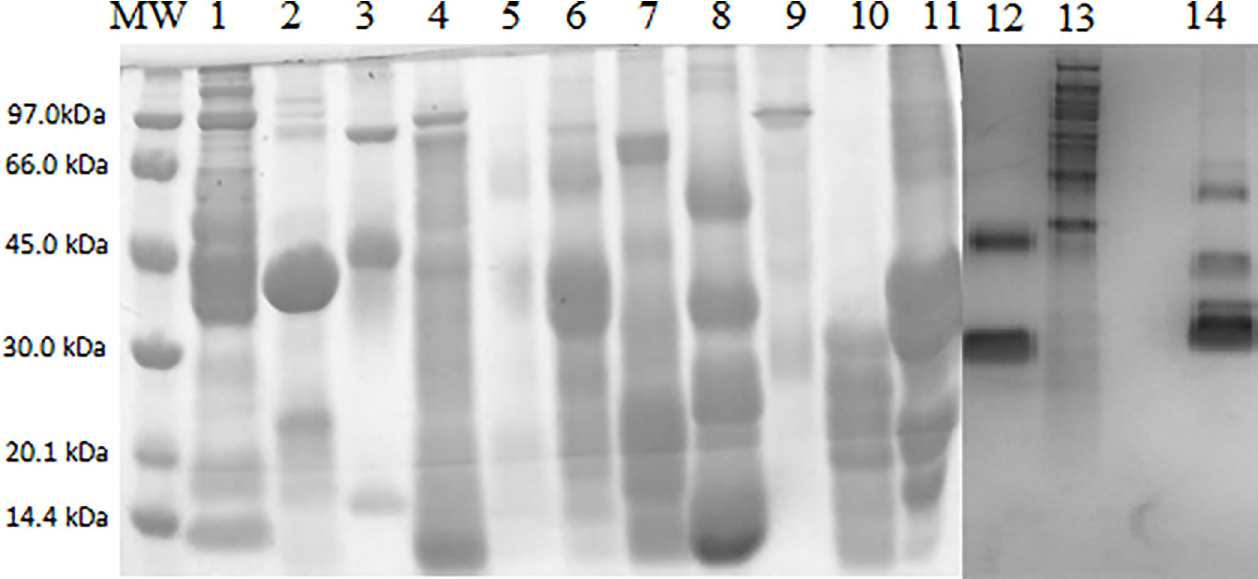
Fig 1. Characterization of total proteins demonstrated in 15% SDS-PAGE stained in Coomassie blue. MW. Molecular Weight, 1. Fish, 2. Shrimp, 3. Clear Egg, 4. Corn, 5. Wheat, 6. Soy, 7. Peanut, 8. Chestnut, 9. Papaya, 10. Kiwi, 11. Milk of cow, 12. Banana, 13. Tomato and 14. Cocoa.